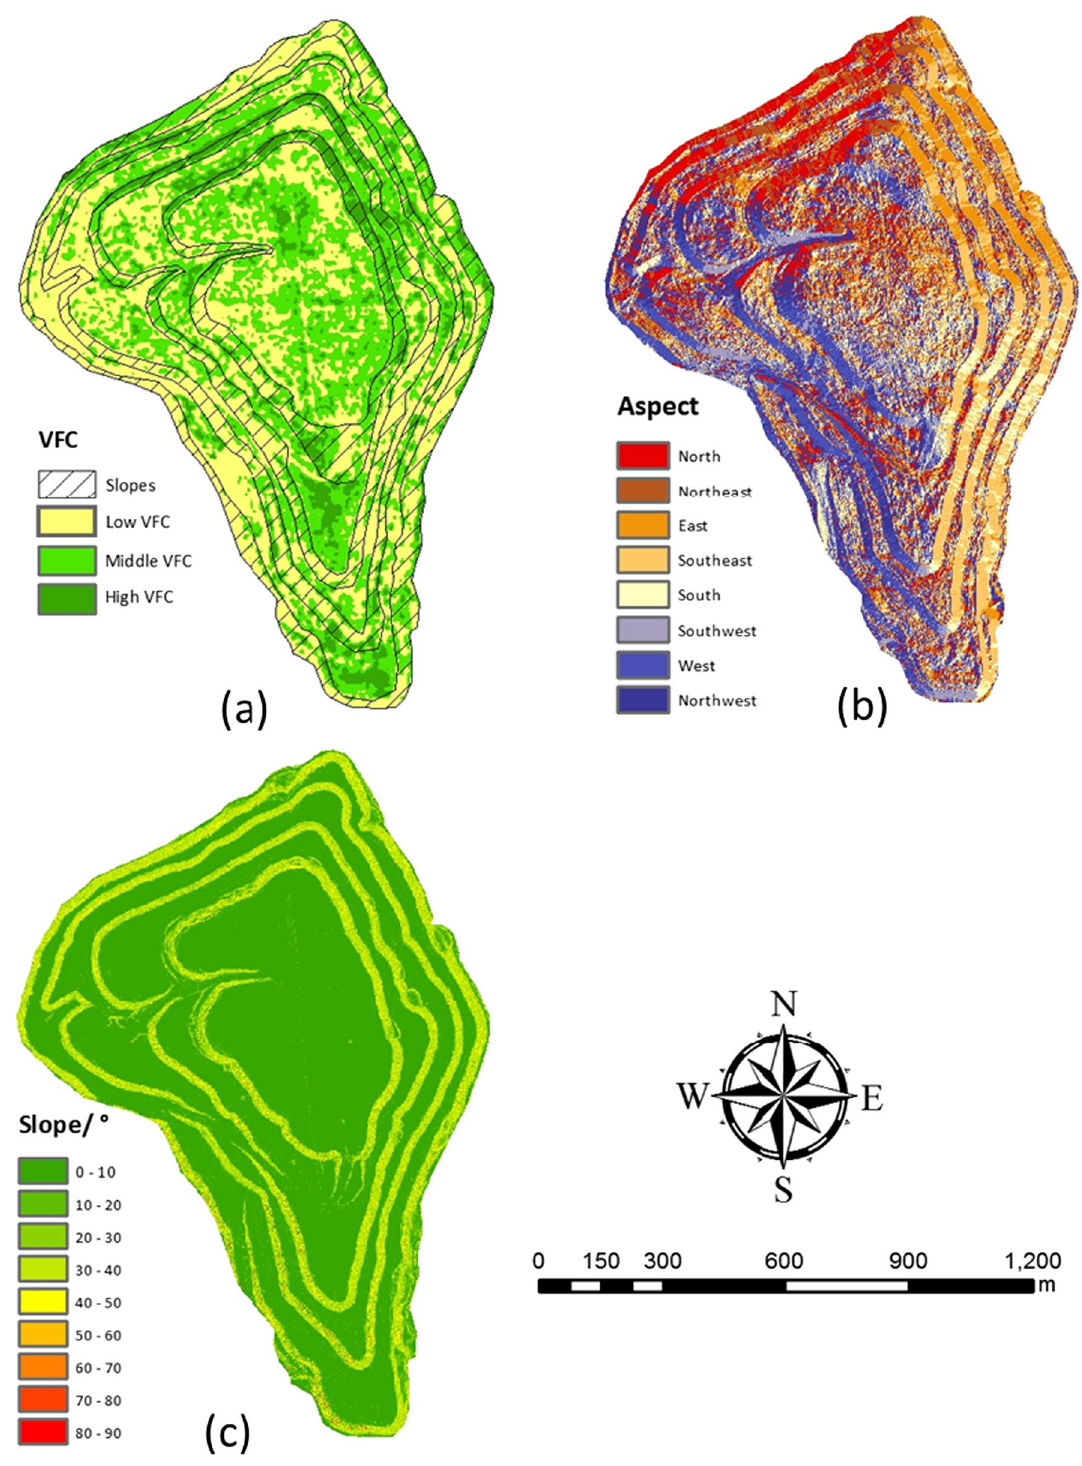
Fig. 7 Map of a VFC, b Slope aspect and c